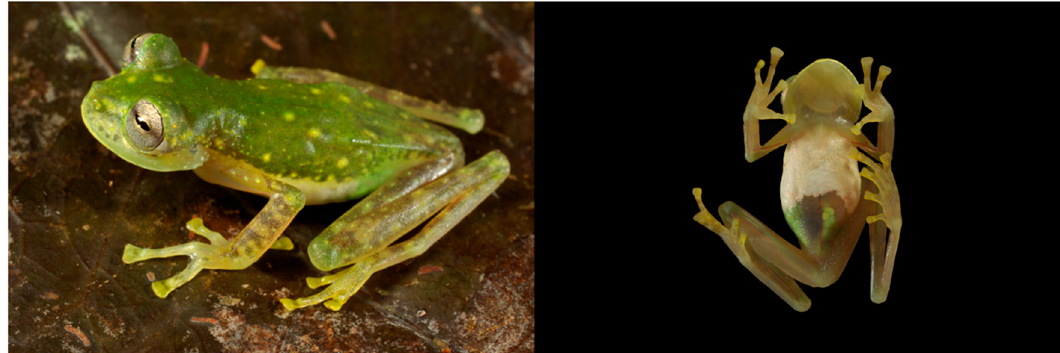
Figure 167. Nymphargus mariae in life. Adult female, QCAZ 37923, from a stream tributary of